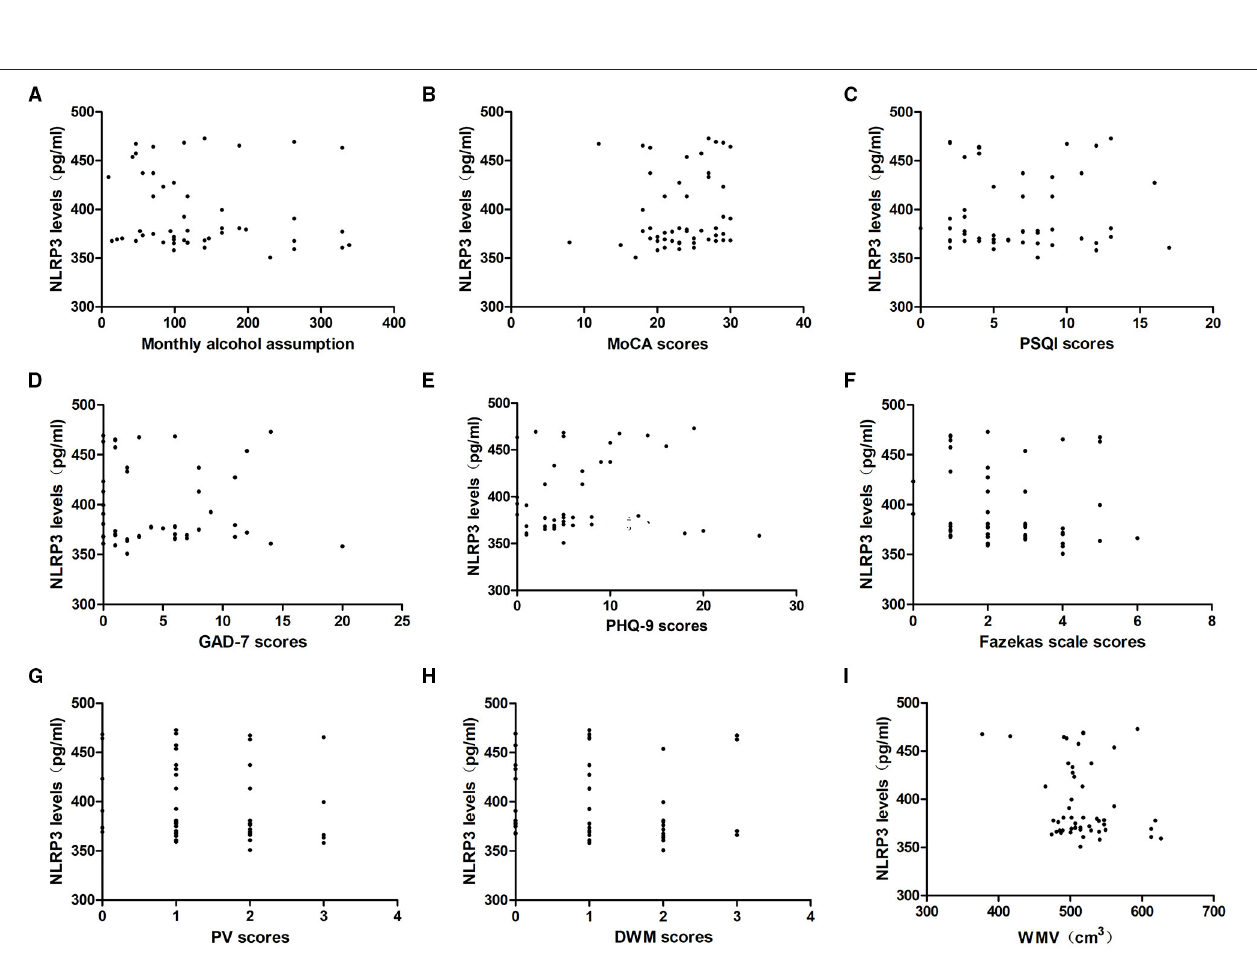
FIGURE 3 | Relationship between serum NLRP3 levels and alcohol assumption, neuropsychological function, the severity of WMLs, and WMV in the alcohol dependence group. Correlation of serum NLRP3 levels with (A) monthly alcohol consumption, (B) MoCA scores, (C) PSQI scores, (D) GAD-7 scores, (E) PHQ-9 scores, (F) Fazekas scale scores, (G) PV scores and (H) DWM scores, (I) WMV. NLRP3 levels were irrelevant to monthly alcohol consumption, MoCA scores, PSQI scores, GAD-7 scores, PHQ-9 scores, Fazekas scale scores, PV scores, DWM scores, and WMV in the alcohol dependence group ( P > 0.05).